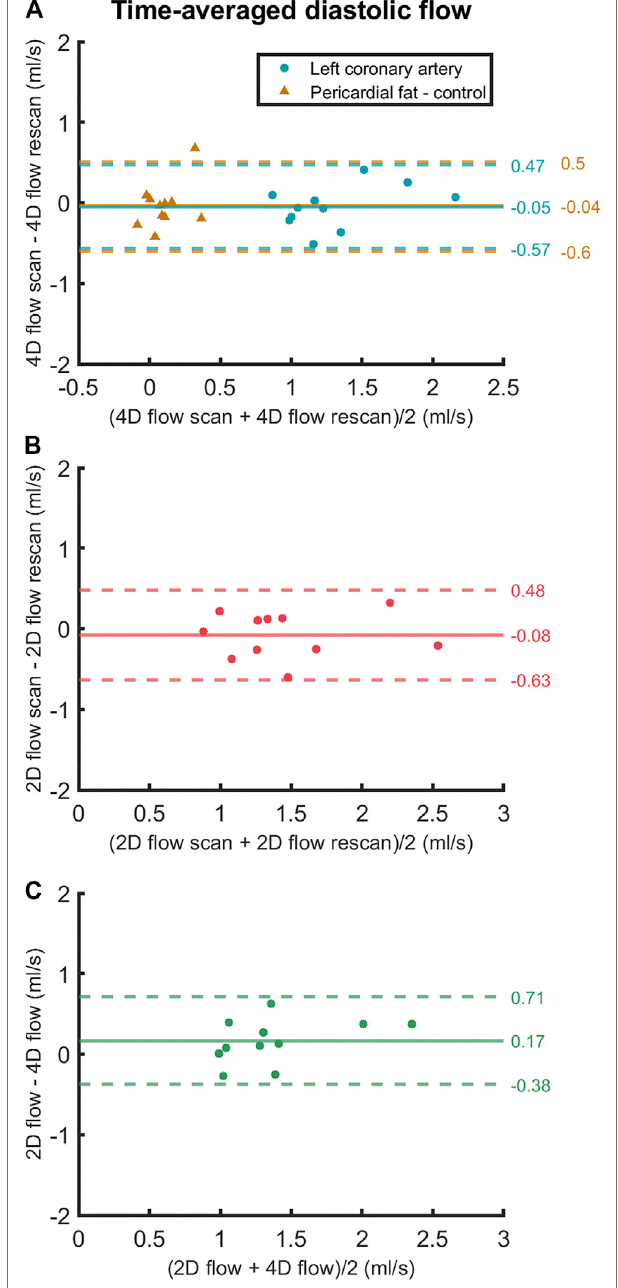
FIGURE 6 | Bland-Altman plots of (A) scan and rescan 4D fl ow MRI measurements, (B) scan and rescan 2D fl ow MRI measurements and (C) 4D fl ow MRI and 2D fl ow MRI scan-rescan-averaged measurements of time- averaged diastolic LCA fl ow. Data points are subject-speci fi c. Mean differences and 95% limits of agreement are indicated on the